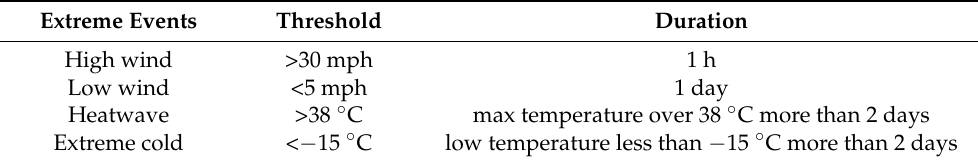
Table 1. Thresholds for extreme temperature and wind speed events. Extreme Events Threshold Duration High wind >30